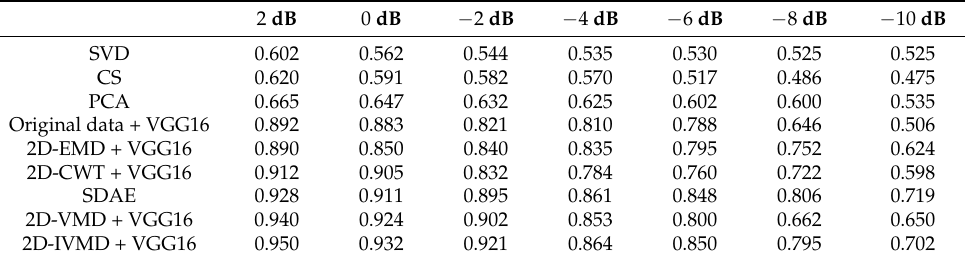
Table 4. Classification performance of the proposed model with several comparable